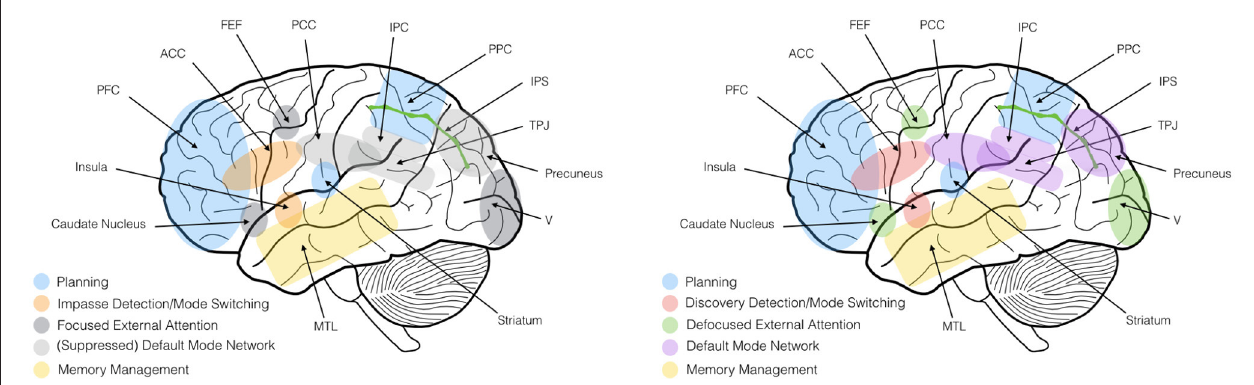
FIGURE 1 | Summary of neural activations during focused problem-solving (Left) and defocused problem-solving (Right) . During defocused problem-solving, the salience network (insula and ACC) coordinates the switching of several networks into a defocused attention mode that permits the reception of a more varied set of stimuli and interpretations via both the internally-guided networks (default mode network DMN) and externally guided networks (Attention). PFC, prefrontal cortex; ACC, anterior cingulate cortex; PCC, posterior cingulate cortex; IPC, inferior parietal cortex; PPC, posterior parietal cortex; IPS, intra-parietal sulcus; TPJ, temporoparietal junction; MTL, medial temporal lobe; FEF, frontal eye field.